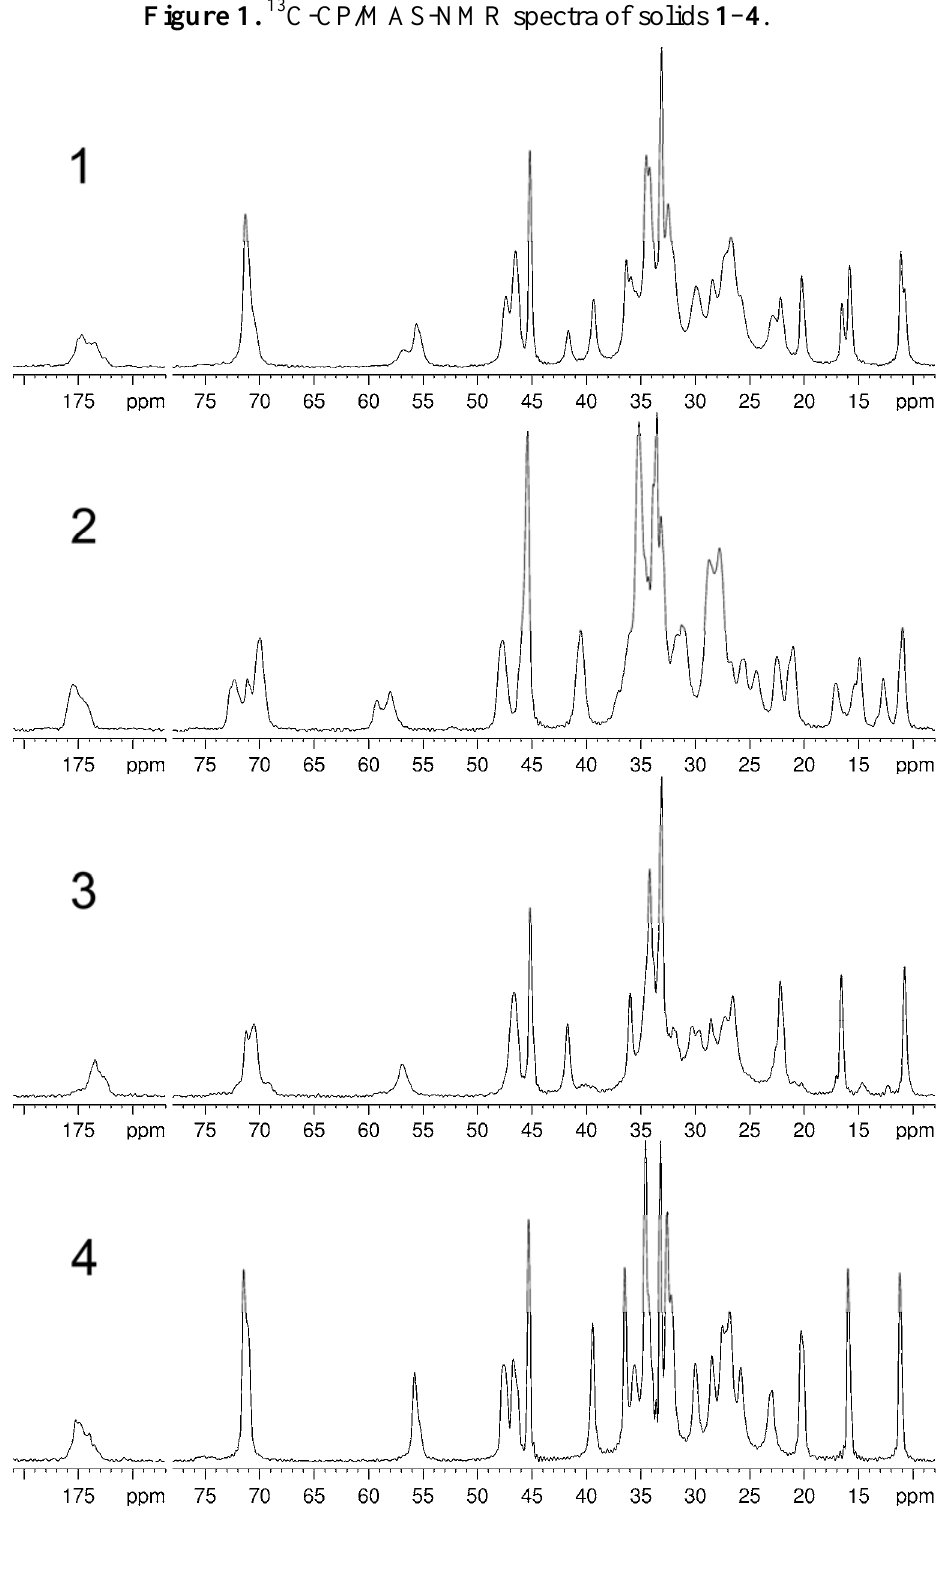
Figure 1. 13 C-CP/MAS-NMR spectra of solids 1 – 4